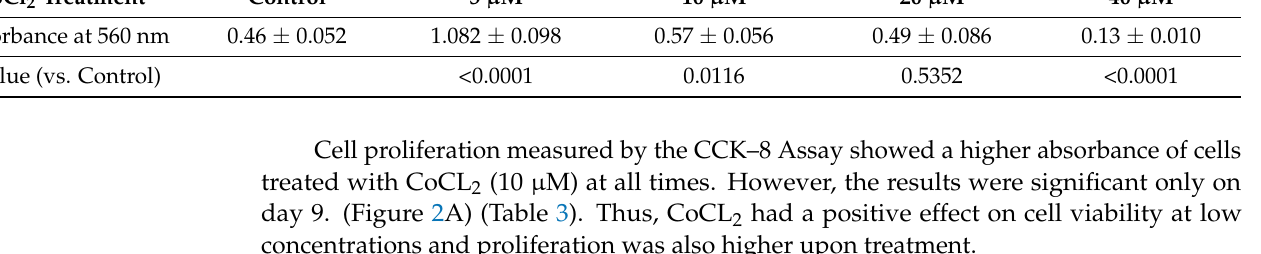
Table 2. Effect of CoCl 2 on viability.